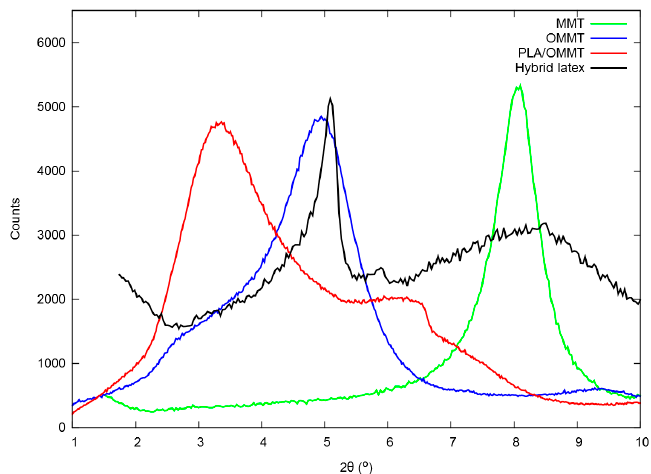
Figure 4. XRD spectra of clays and their mixtures with PLA. The d 001 are 1.1 nm (MMT), 2.1 nm (organically-modified MMT (OMMT)) and 3.1 nm (PLA/OMMT). The hybrid latex presents two diffraction peaks, similar to the d 001 of both clays (MMT and OMMT). The spectra were vertically adjusted to display similar count values.